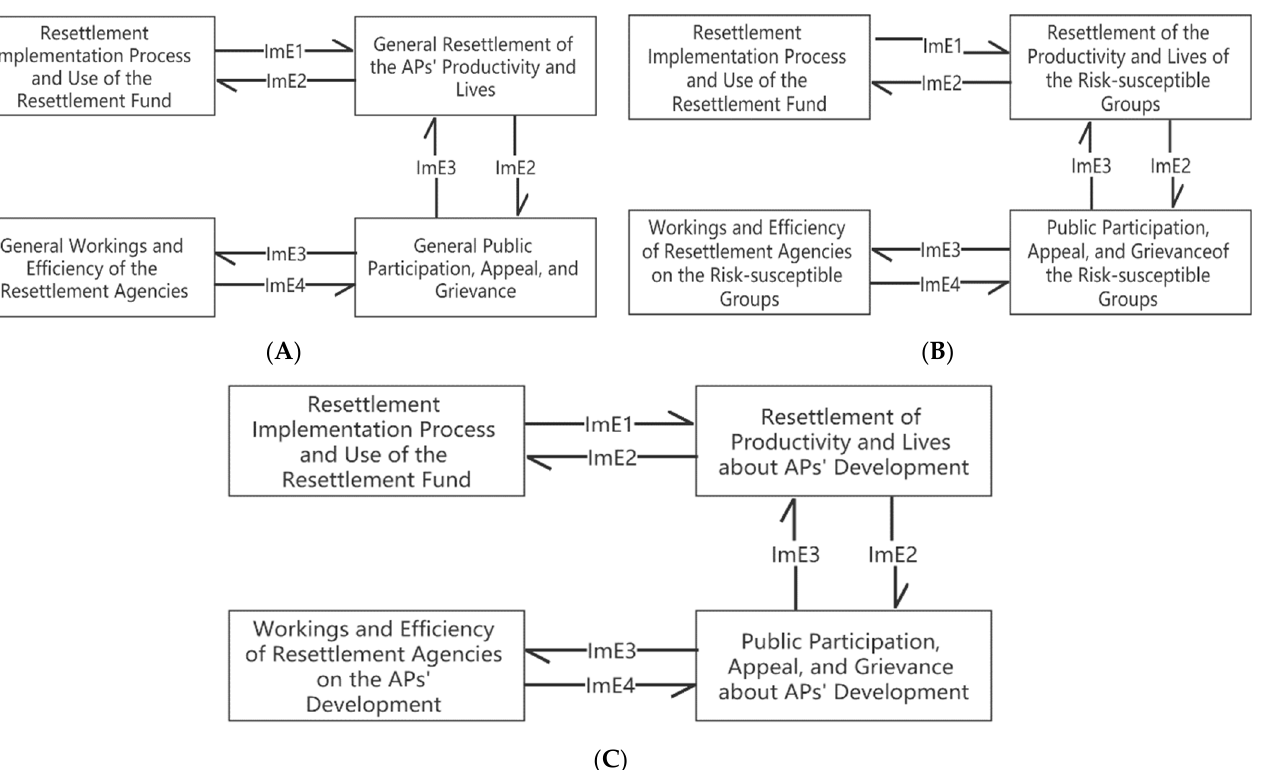
Figure 5. The Framework for the Updated Evaluation Model of Involuntary Resettlement based on the Meta-model of Evaluation. ( A ) General Evaluation of the Resettlement. ( B ) Evaluation of the Risk-susceptible Groups. ( C ) Evaluation of the Development of the Aps.